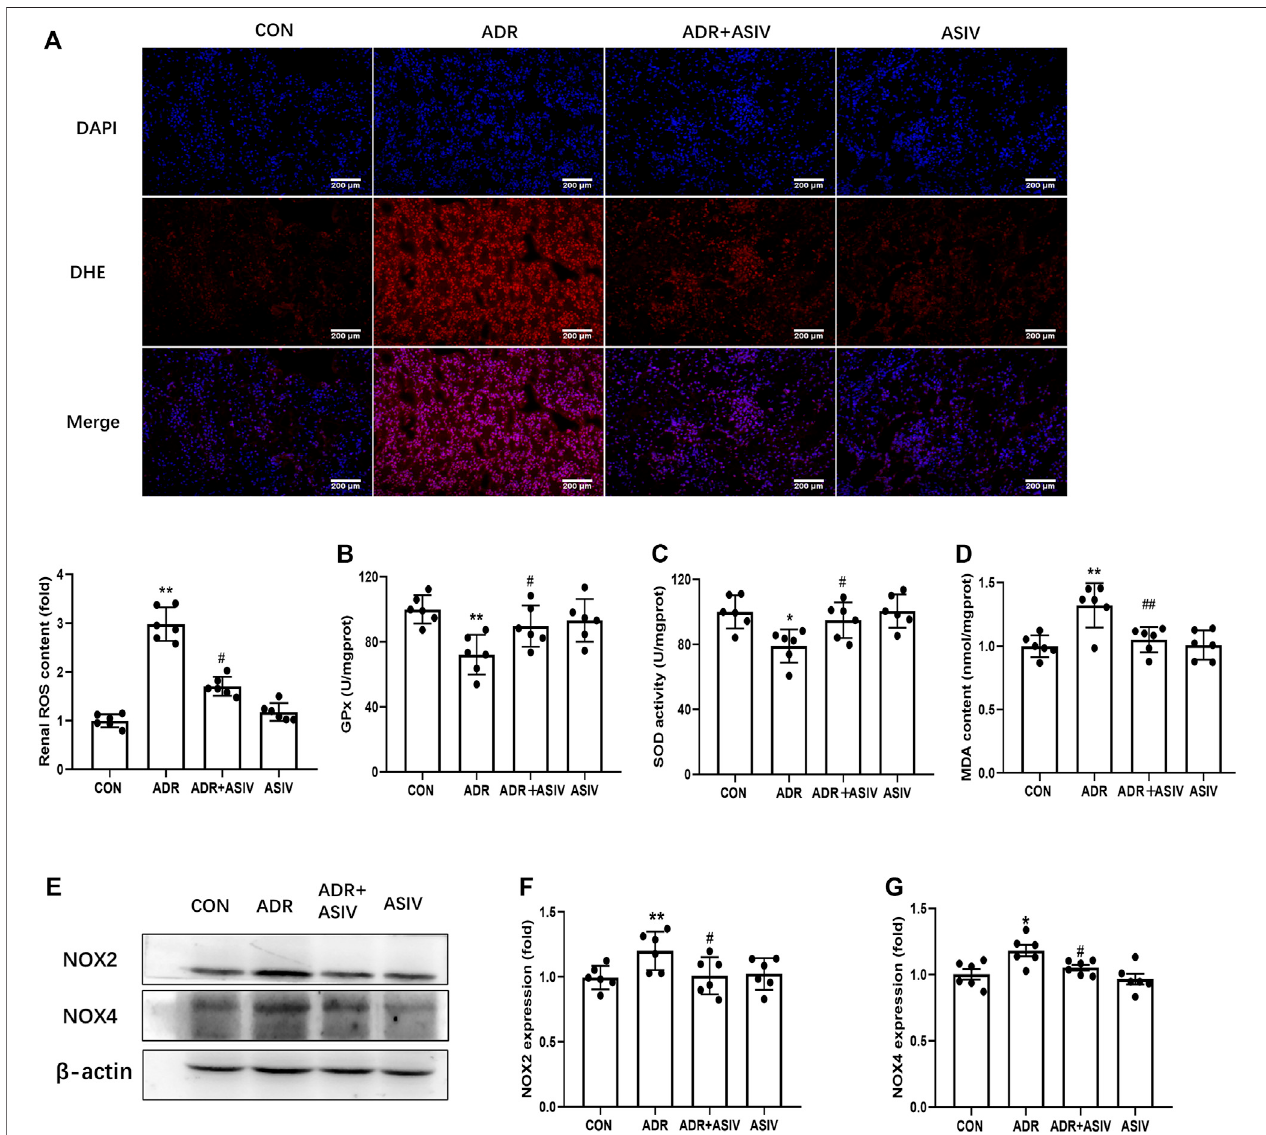
FIGURE 2 | ASIV reduced ADR-induced oxidative stress. (A) Representative images of DHE staining and quanti fi cation of ROS production. DHE positive (red), nuclear stained with DAPI (blue). Serum GPx (B) , SOD (C) , and MDA (D) levels among the different groups ( n = 3). (E) Protein expression of oxidative stress-associated proteins, including NOX2, NOX4 in kidney tissue. (F,G) The expression of NOX2 and NOX4. Data were expressed as mean ± SD, n = 6. * p < 0.05, ** p < 0.01 vs. CON group. # p < 0.05, ## p < 0.01 vs. ADR group.